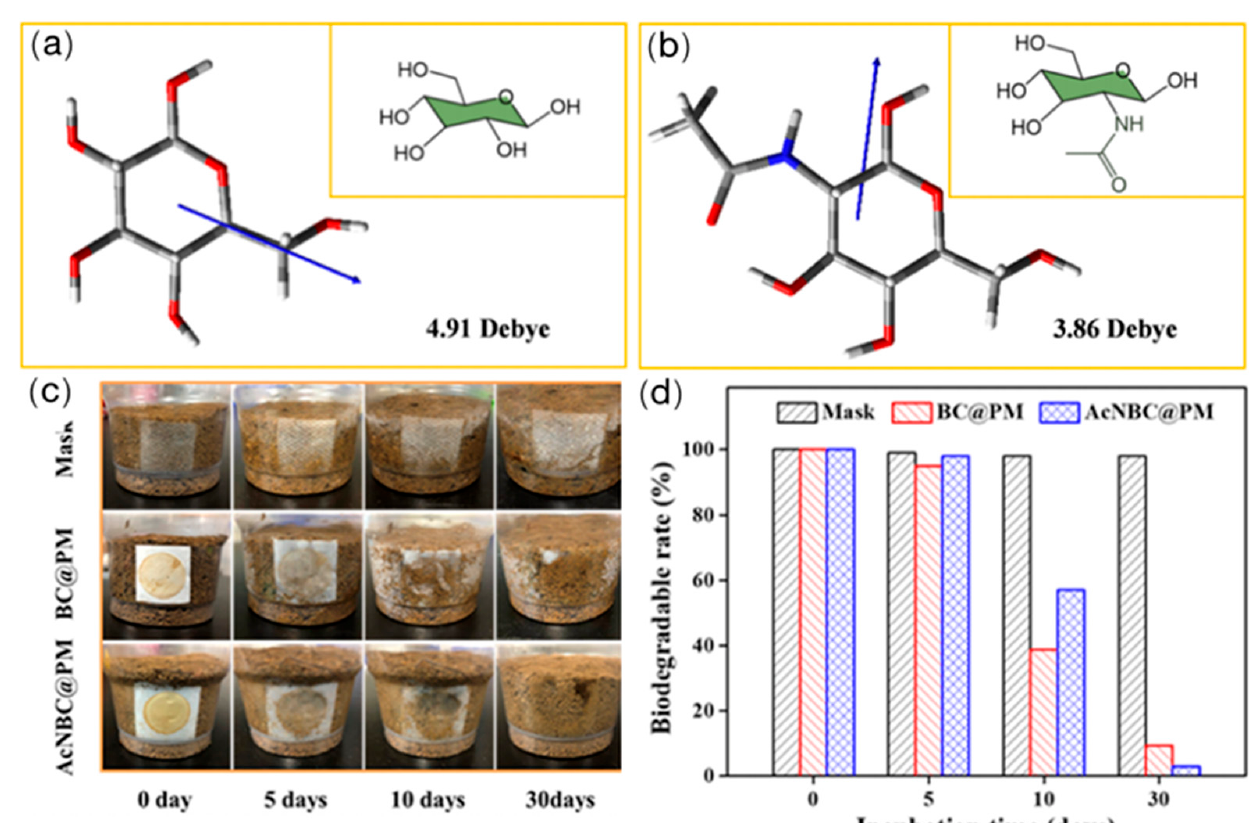
Figure 7. ( a , b ) Molecular model and the corresponding dipole moments of BC and AcNBC. ( c ) Photographs of the commercial mask, BC, and AcNBC filters at different incubation times in the soil. ( d ) Biodegradable rate of the BC, AcNBC filters, and commercial masks by calculating the area of the filters [111] .